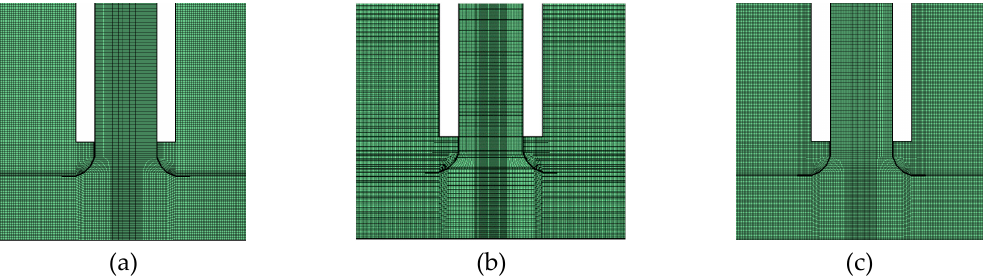
Figure 5. CFD Mesh for Grid Independence Study. ( a ) Coarse Mesh, ( b ) Medium Mesh, ( c ) Fine Mesh.